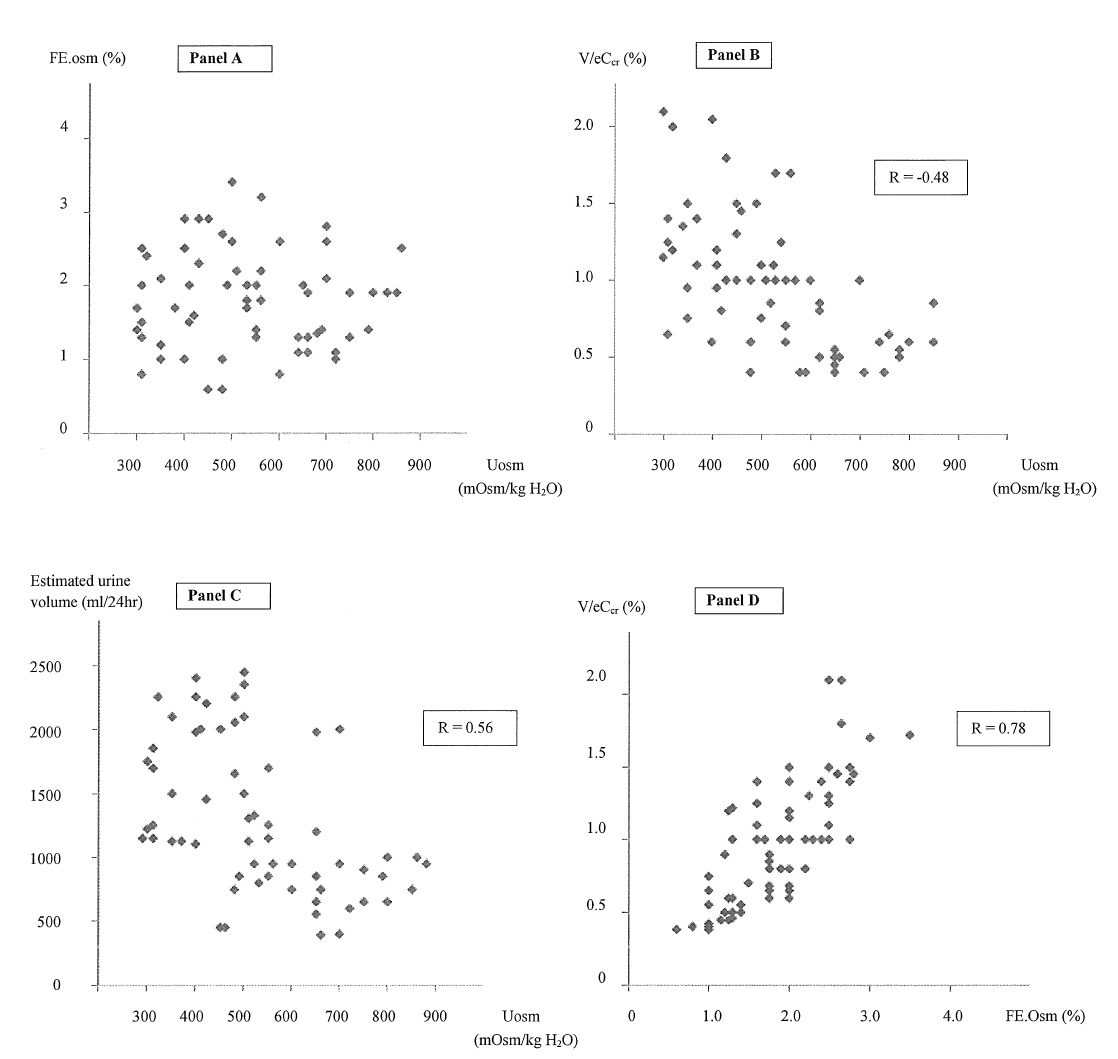
Figure 3. Correlation between the calculated urine volume and the measured values in 35 controls and 30 patients with chronic hyponatremia due to SIADH. In six patients, represented by a number in brackets, the values are given before and after treatment with urea (see Table 3). Further, 13 patients presented an estimated daily urine volume ≥ 2000 mL, associated with a high solute intake (> 900 mmol/24 h in 10 patients; Figure 4) and 19 patients presented a daily low solute intake <500 mmol, associated with a low urine volume (< 1000 mL/24 h in 13 patients).